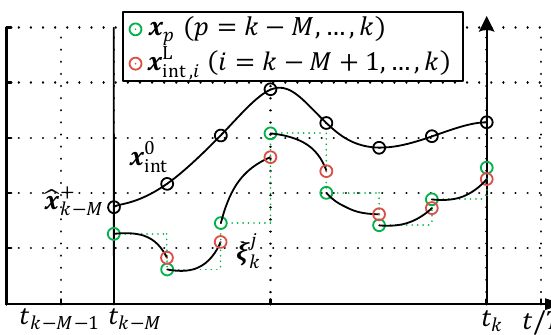
Figure 13. Schematic representation of a moving measurement window.